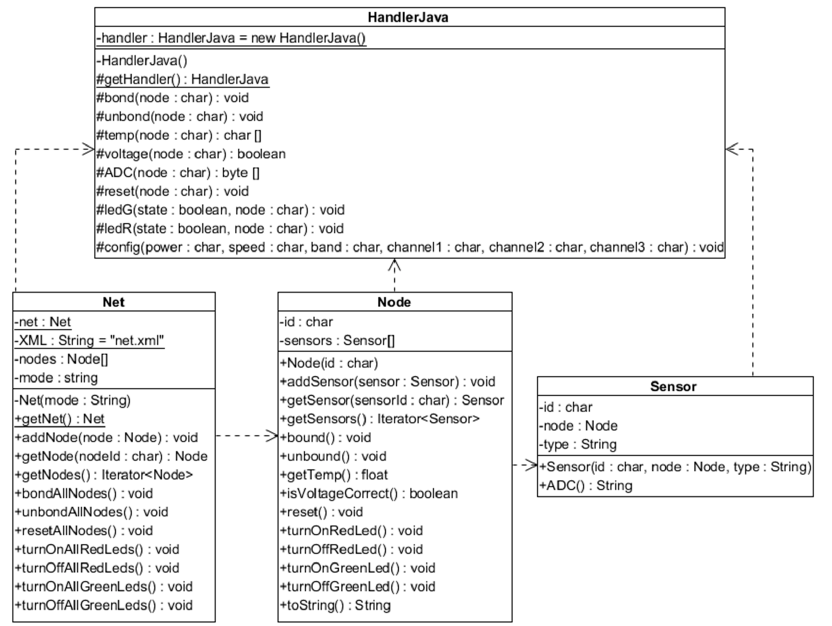
Table 3. C bindings for controlling the IQRF network from the Raspberry Pi.